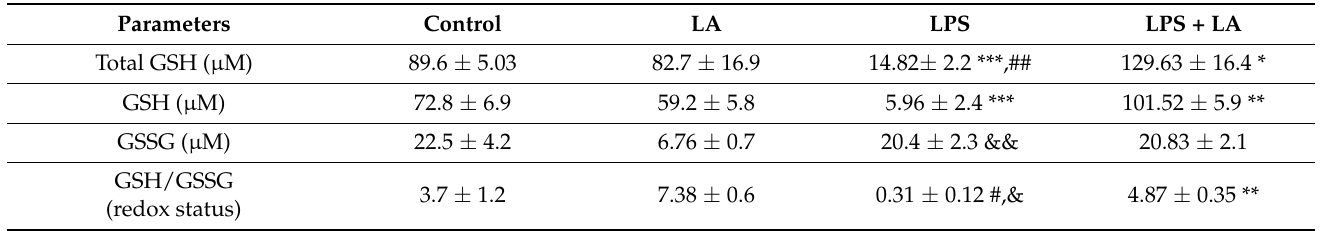
Table 2. Ventricles status of glutathione metabolism in the control, LA, LPS, and LPS + LA groups. Parameters Control